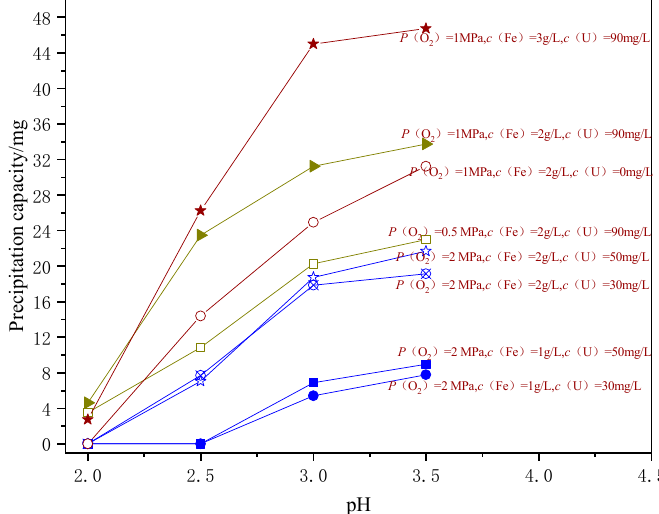
Figure 13. Effect of concentration and pH on iron precipitation.